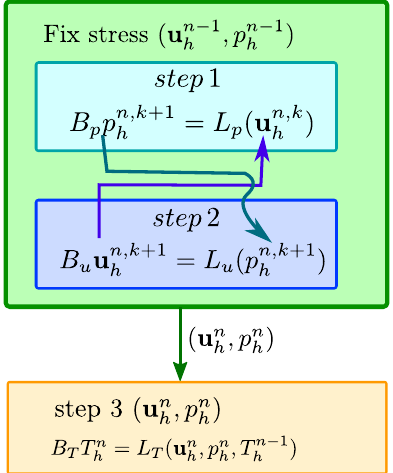
Ω Γ marks the top surface of the basin. out ). ∪